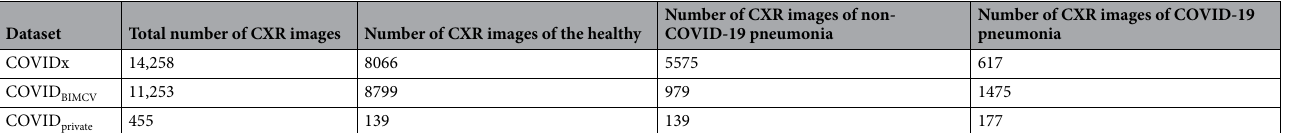
Table 1. Numbers of CXR images in the COVIDx, COVID BIMCV , and COVID private datasets. All cases of non- COVID-19 pneumonia are bacterial pneumonia in COVID private . CXR chest X-Ray imaging; COVIDx public dataset used for COVID-Net; COVID BIMCV public dataset obtained from the PadChest dataset and the BIMCV- COVID19 + dataset; COVID private private dataset collected from six hospitals.